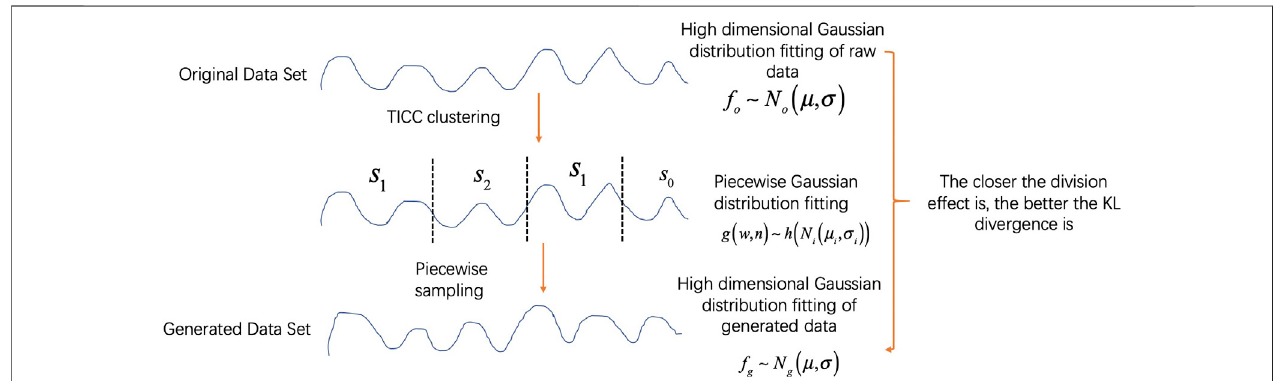
FIGURE 3 | Kl distance calculation based on